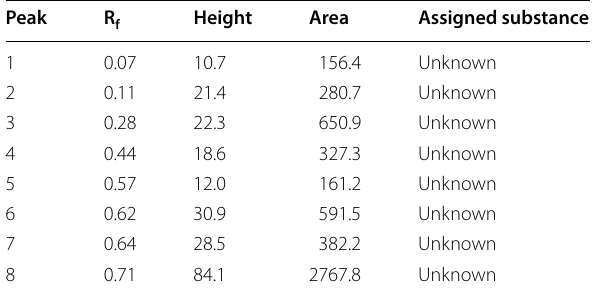
Table 14 Peak table of BPSAQ in mobile phase III